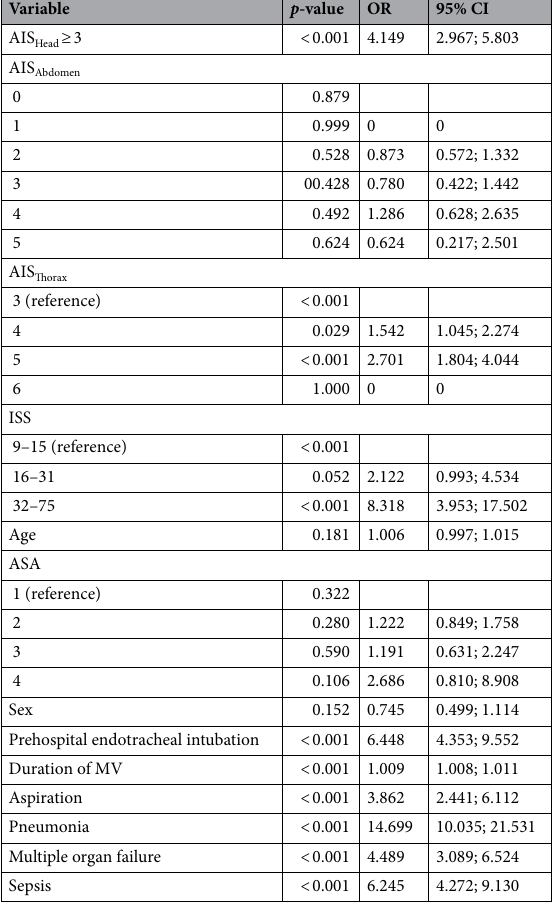
Table 2. Univariable binary logistic regression analyses with “tracheostomy” as the dependent